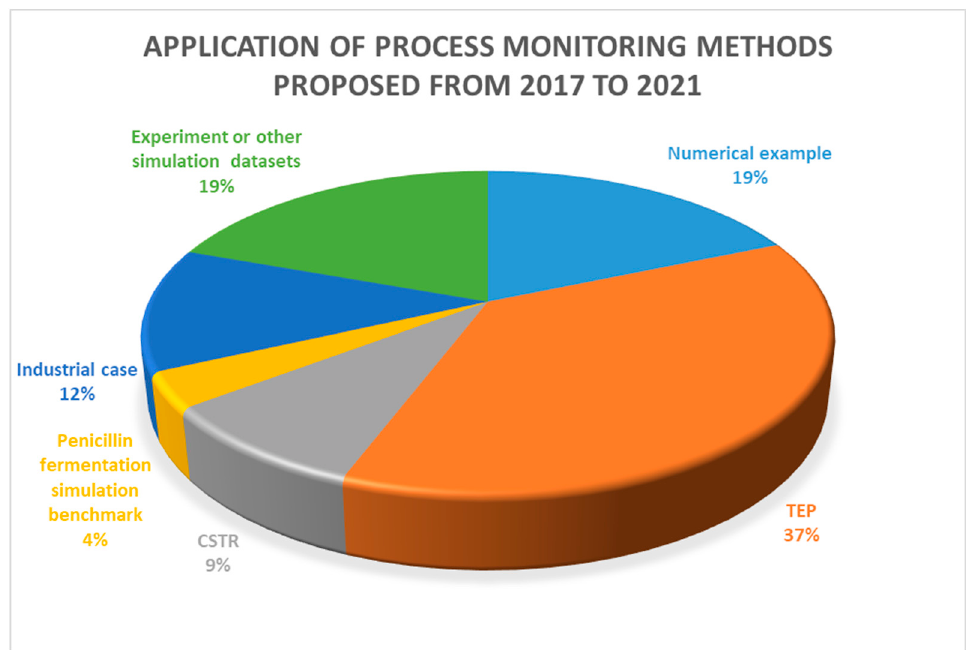
Figure 1. A statistic on the application of process monitoring methods.